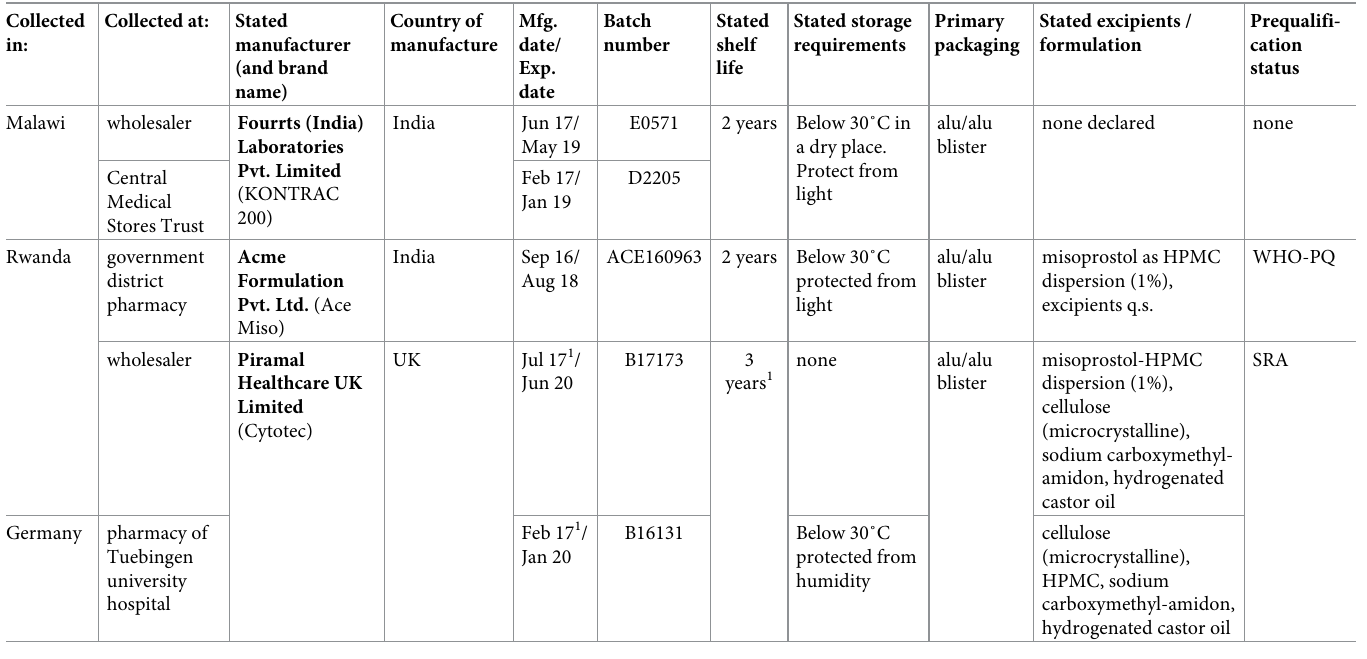
Table 1. Investigated misoprostol samples. All samples represented tablets with a stated content of 200 μ g/ tablet. Collected